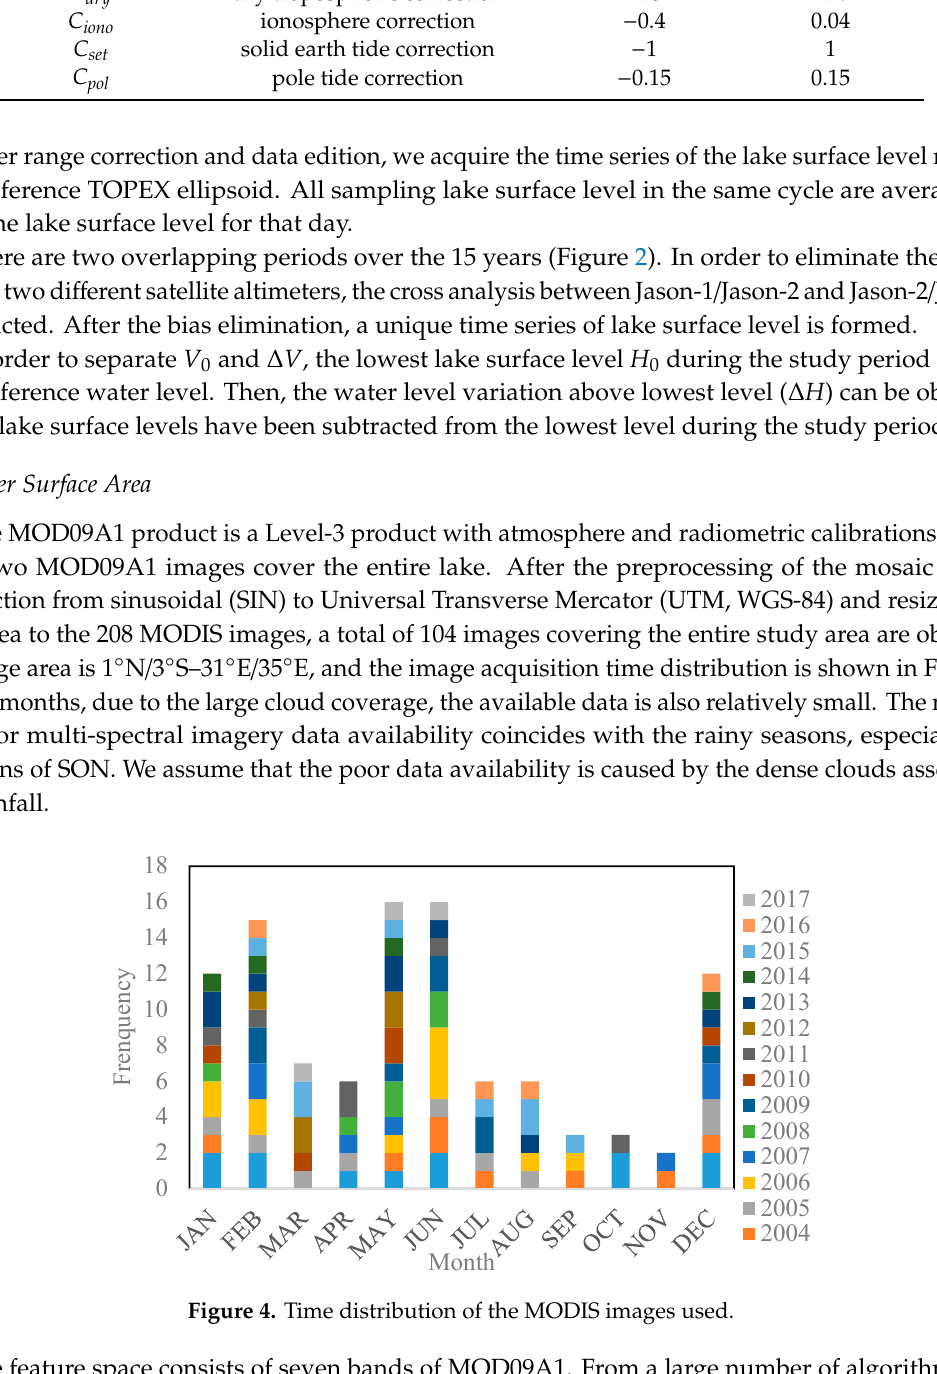
Table 2. Correction threshold editing elements of the Jason series altimetry data (Unit: m).